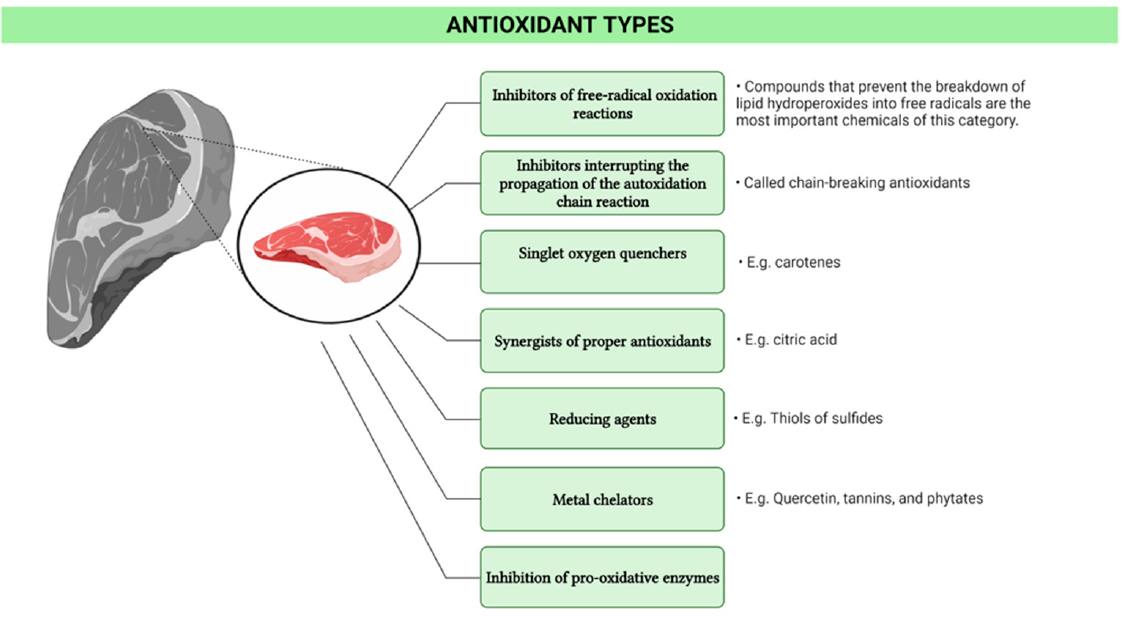
Figure 1. Antioxidant types based on their mechanism of action (illustration made via www.BioRender.com, accessed on 9 March 2023).